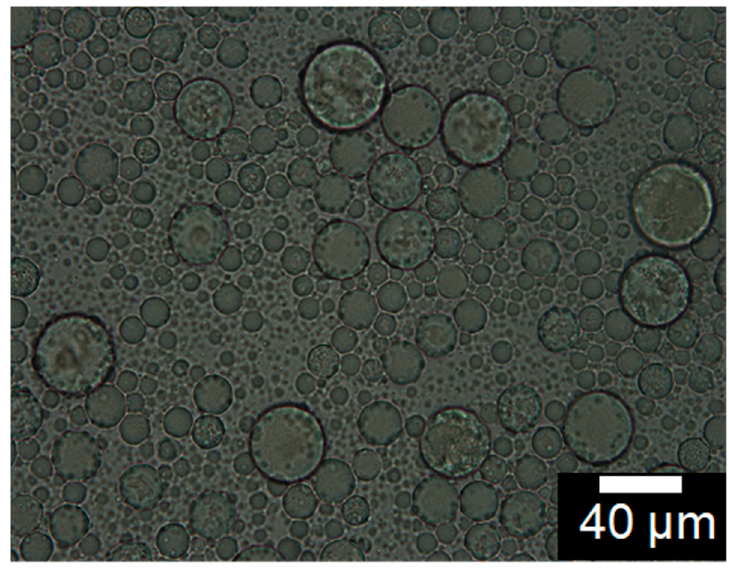
Figure 1. Photomicrograph of W 1 /O/W 2 multiple emulsion.